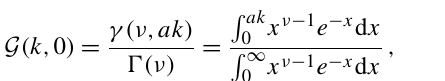
Table 1. Parameters and variables with associated units. When two values are specified in the value column, they refer to respectively sPOC and bPOC. Symbol Description Units Value ν Shape parameter of the gamma distribution – 1.0 a Average lifetime of the more reactive component d See Table 2 t ∗ Pseudo time variable d f (T )t T Temperature ◦ C Variable POC Particulate organic carbon mmolm − 3 Variable sPOC Small particulate organic carbon mmolm − 3 Variable bPOC Large particulate organic carbon mmolm − 3 Variable − 1 See Table 2 e k Mean degradation rate of fresh POC d k i Boundary in the lability space d − 1 From Eq. (5) G ( ¯ k i ,t) Fraction of POC with degradation rate ∈ [ k i ,k i + 1 [ – Variable G mxl ( ¯ k i ,t) Mean G ( ¯ k i ,t) in the mixed layer – From Eq. (9) ¯ k ¯ k i Mean degradation rate of G ( i , 0 ) d From Eq. (7) P POC Production of POC molm − 3 d − 1 Variable Sink of POC Settling speed of POC Depth of the mixed layer Mean degradation rate of POC Mean temperature in the mixed layer Variable Temperature dependency of degradation rate Variable Exponent of the Martin et al. (1987) power law